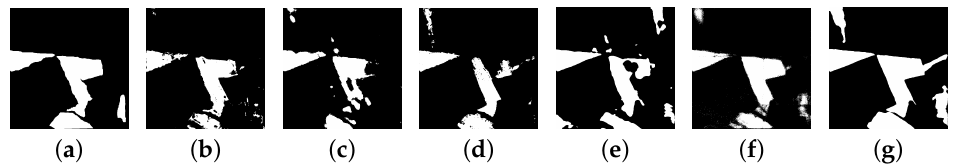
Figure 13. Result examples of different change detection algorithms on the Tiszadob of SZTAKI dataset. ( a ) ground truth map, ( b ) FC-Siam-conc, ( c ) FC-Siam-diff, ( d ) U-Net, ( e ) DSMS-CN, ( f ) SNUNet, ( g ) MSAK-Net-MCRF.